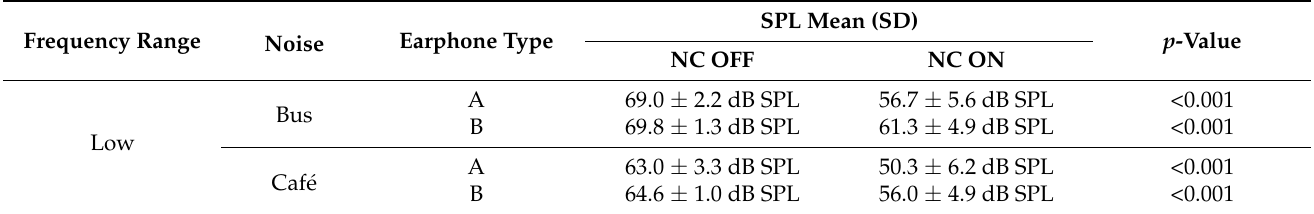
Table 2. HL group’s mean and standard deviation of SPLs for the two types of earphones in bus and caf é